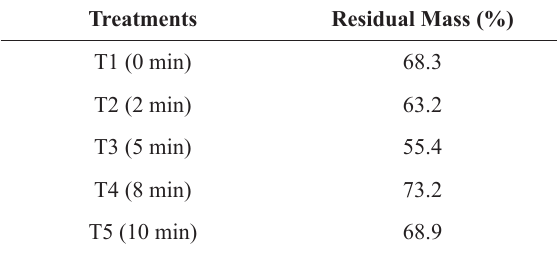
Percentage residual masses of each treatment. Treatments